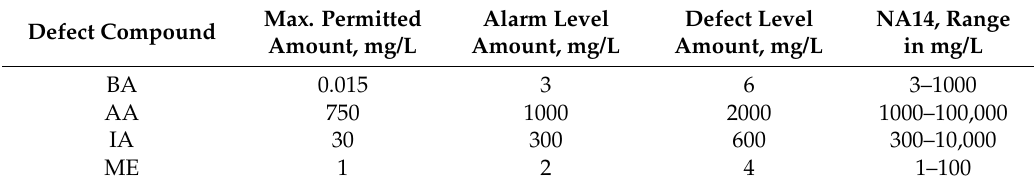
Table 3. The amounts of wine defect compounds in artificial wine calibration solutions and in Negroamaro wine